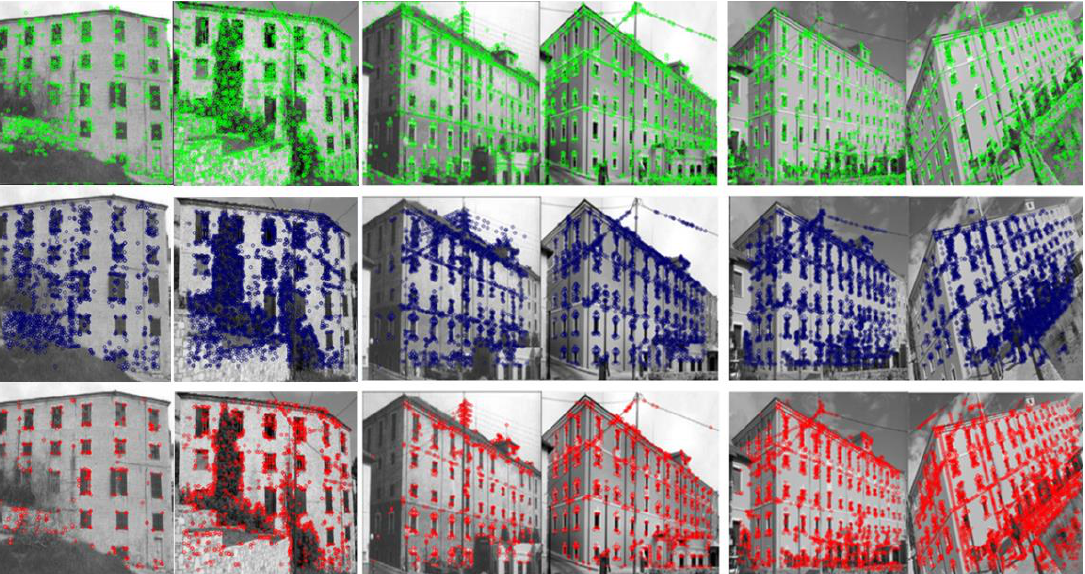
Figure 12. Tobacco industry building: detection of keypoints. The first pair of buildings is historic (1990 – 1992), the second pair has 20 years of distance (2000 – 2021), while the third pair of buildings is modern and of the same year (2022). Green, blue, and red keypoints indicate SIFT, ORB, and BRISK algorithms, respectively.